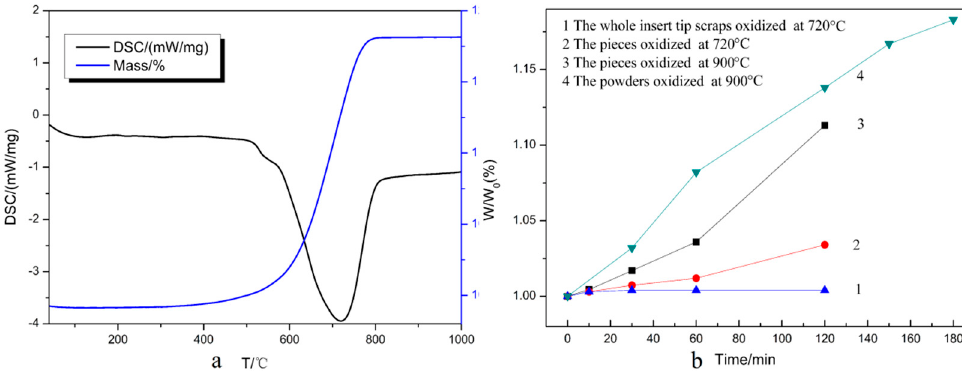
Figure 4. ( a ) TG-DSC curves of the coated multicomponent hardmetal oxidized under air flow; and ( b ) weight ratios versus oxidation time.